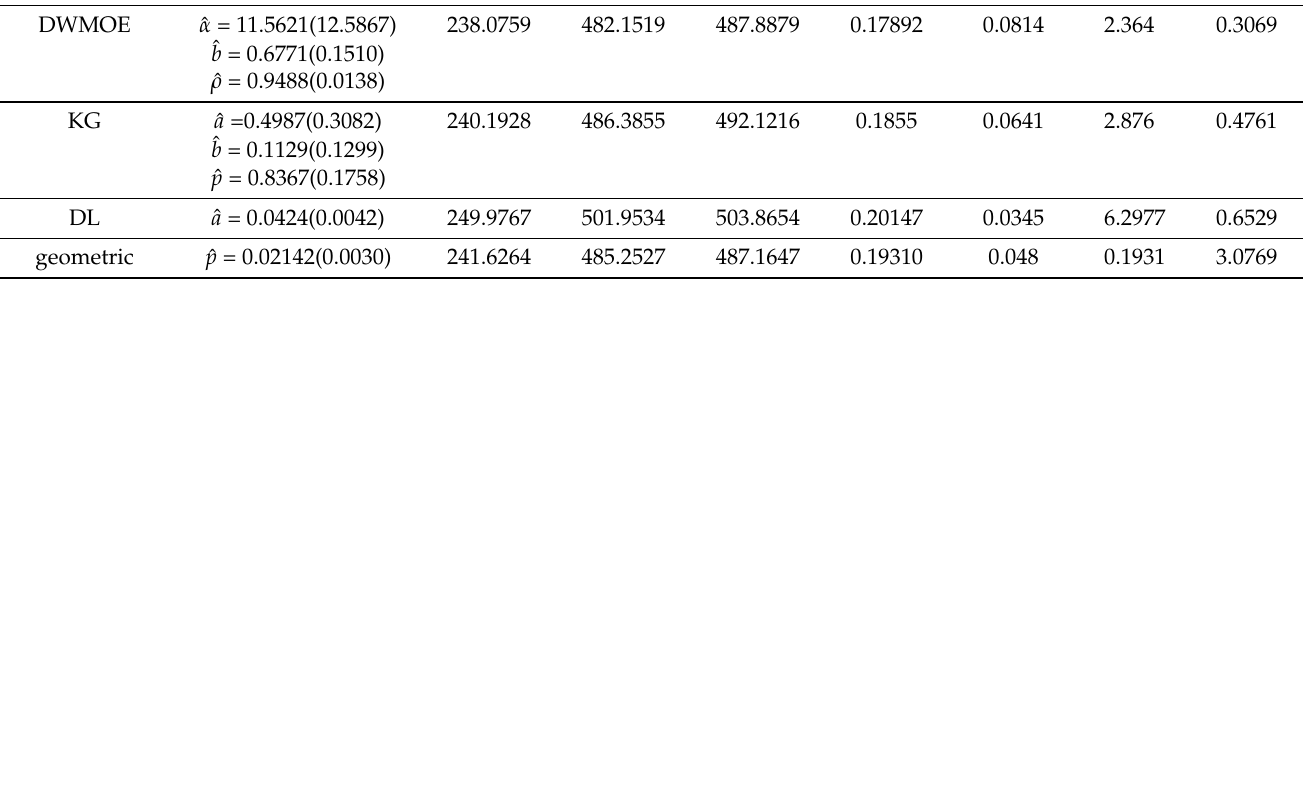
Table 6. Estimated values, − logL, AIC, BIC, K-S statistics, p -value, A ∗ and W ∗ for data set 2.